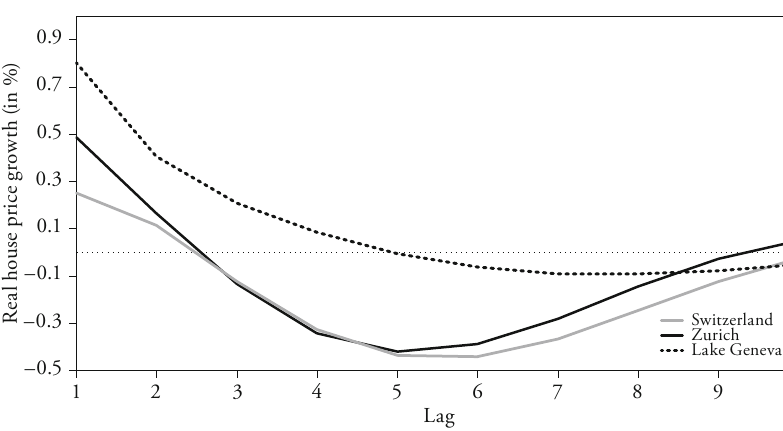
Figure 14: Regional Analysis: Response of House Prices to a Shock on Mortgage Rate